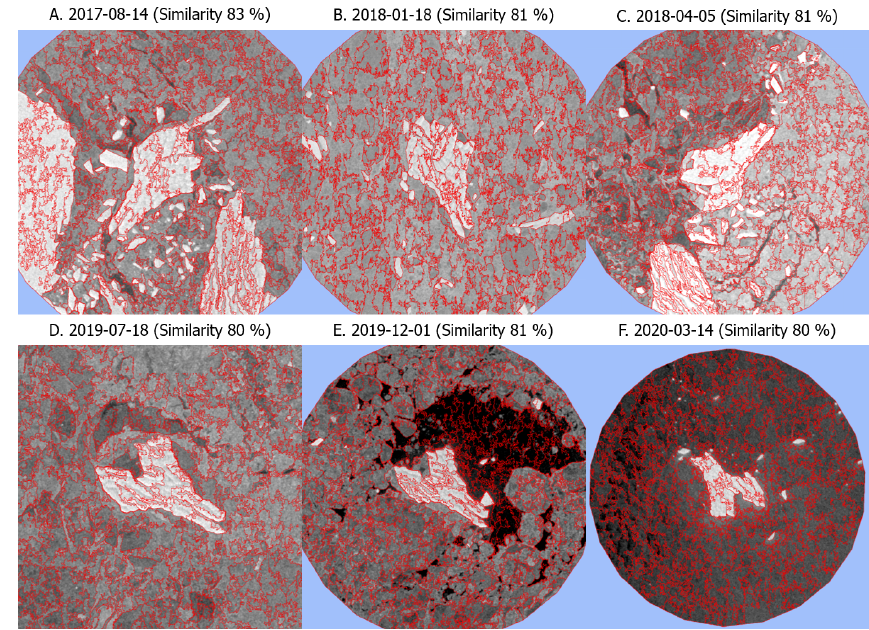
Figure A2. Sentinel-1 SAR images and SNIC segmentation results for six low-similarity times A–F in Fig. A1.